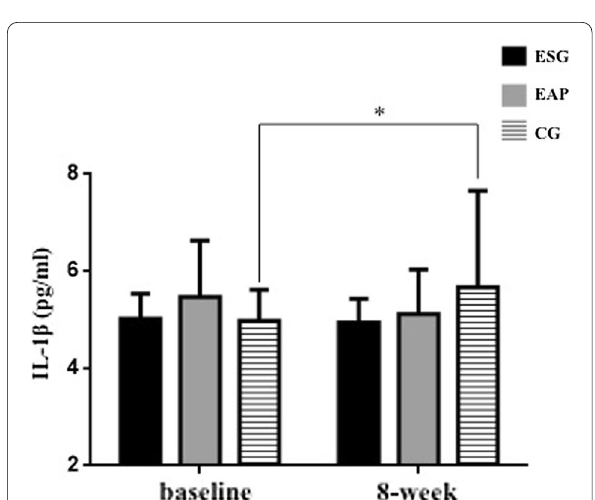
Fig. 4 Values of IL-1β concentration baseline and 8-week for all the experimental groups. IL-1ß: interleukin-1ß; ESP: exercise and sham PBM group; EAP: exercise and active PBM group; CG: control group. * Statistical significance between in the baseline and 8-week intervention